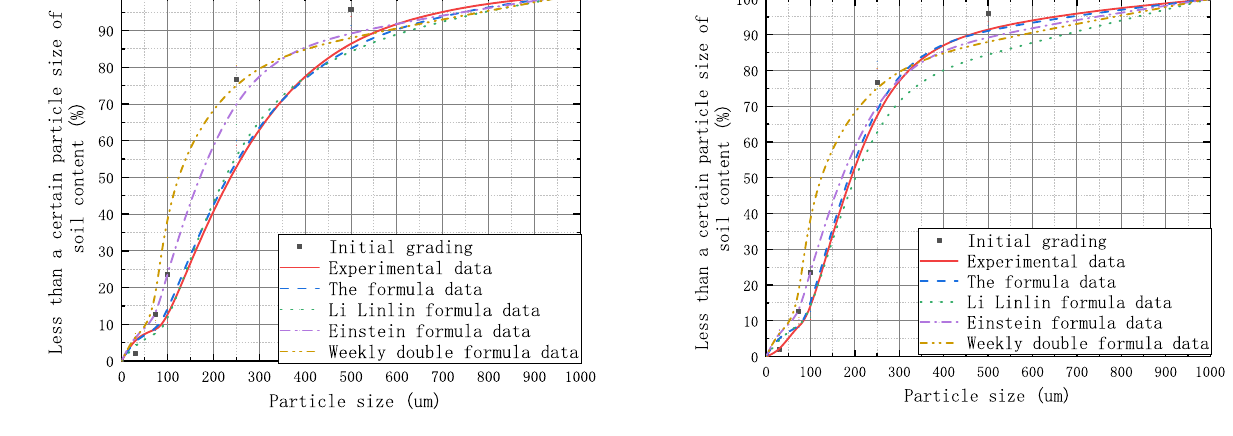
Figure 7. Comparison of calculated and experimental data in the second